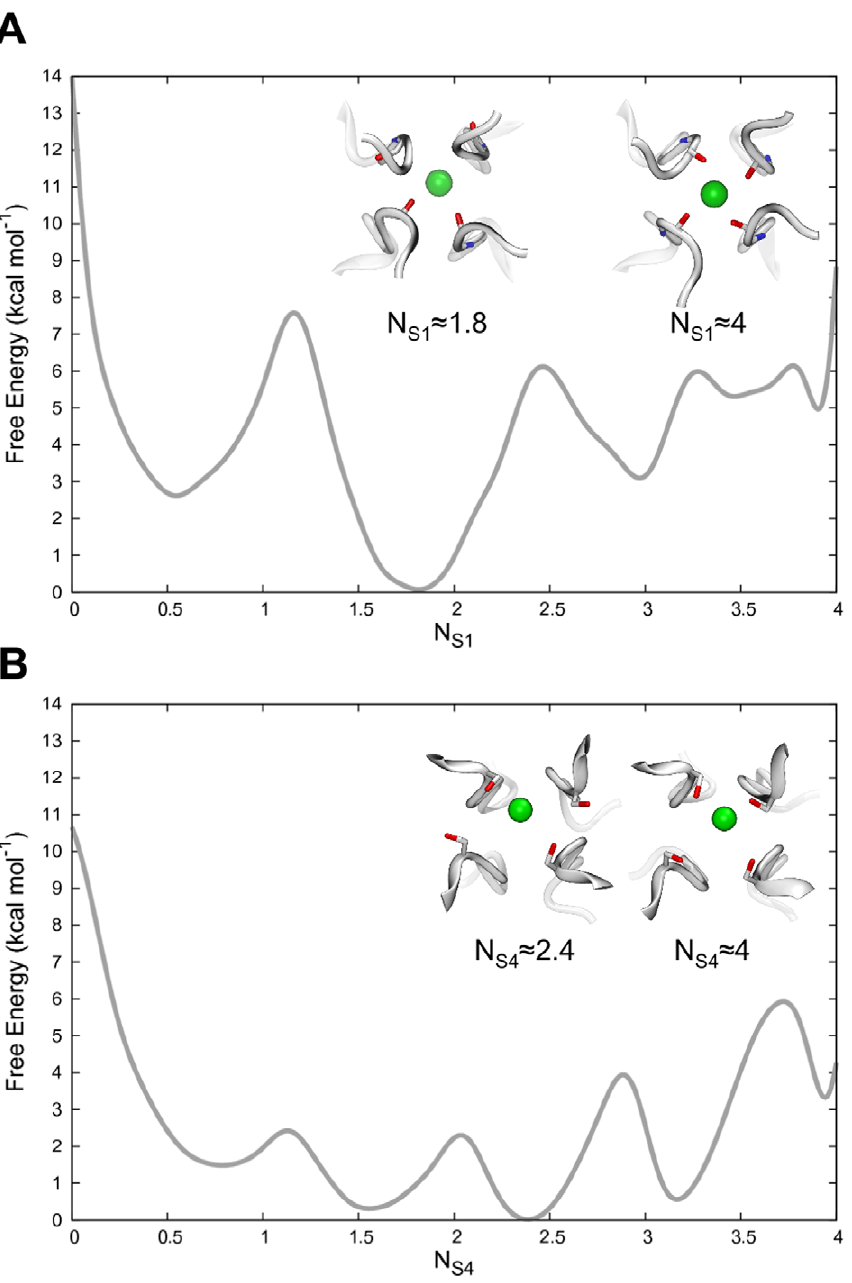
Figure 5. Stability of the coordination sites S1 and S4. Free energy profiles describing the stability of the coordination sites S1 and S4 as a function of N S1 (panel A) and N S4 (panel B), respectively. In both cases, the S5,[S3,S1] occupancy state of the filter was used. In the insets, representative configurations of the filter are